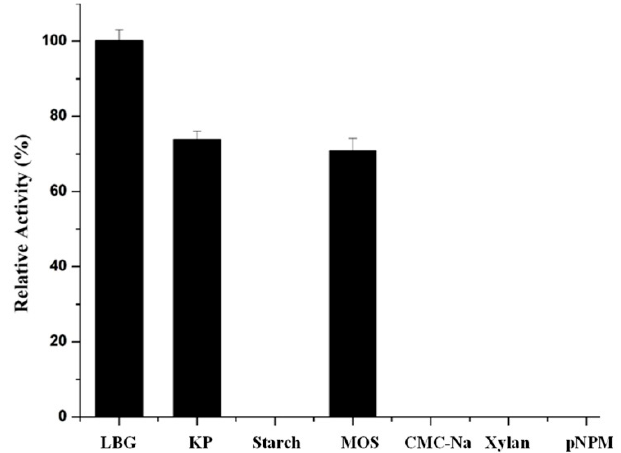
Figure 8. Substrate specificity of the recombinant Man26E. LBG: locust bean gum; KP: konjac powder; MOS: manno-oligosaccharides; pNPM: p -nitrobenzene- D -pyranoside.